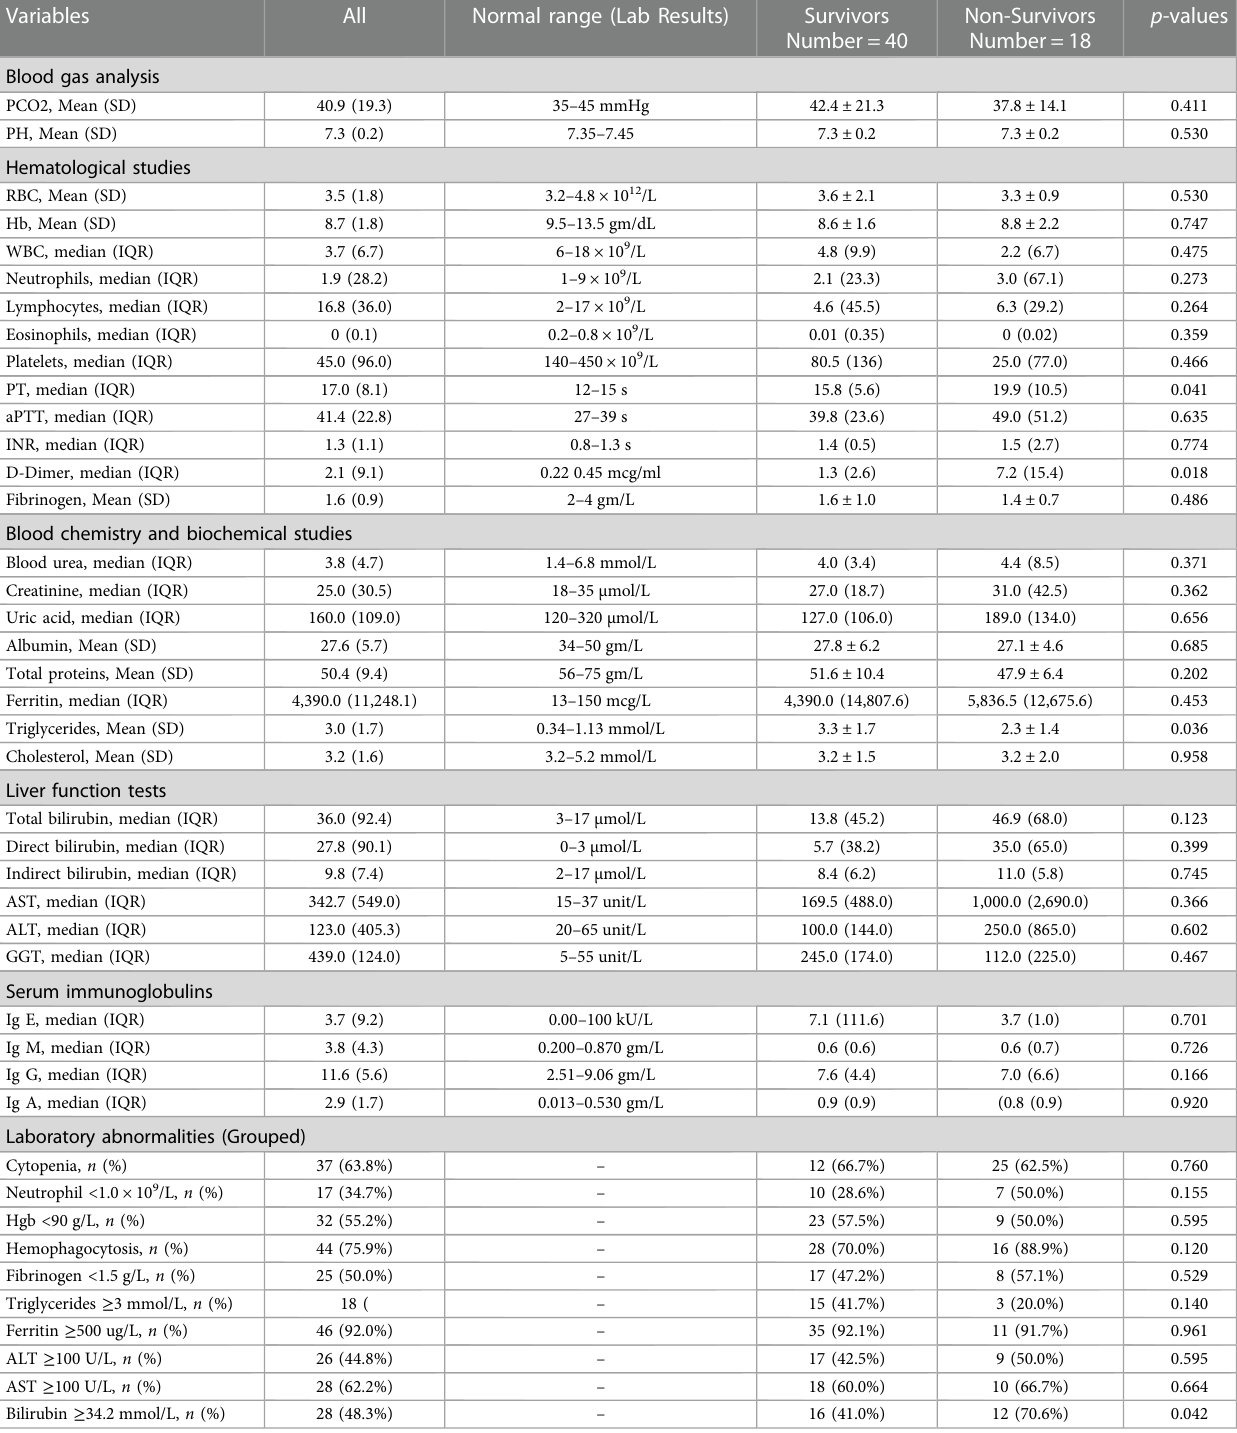
TABLE 3 Comparison of laboratory characteristics upon admission between survivors and non-survivors. Variables